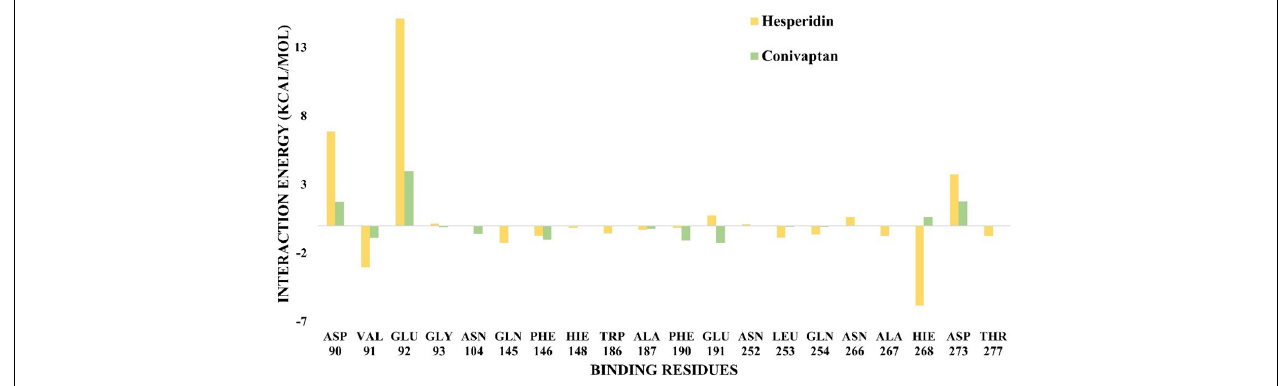
FIGURE 6 | Binding free energy decomposition plot. Decomposition plot of binding free energy over the interacting residues at the active site of